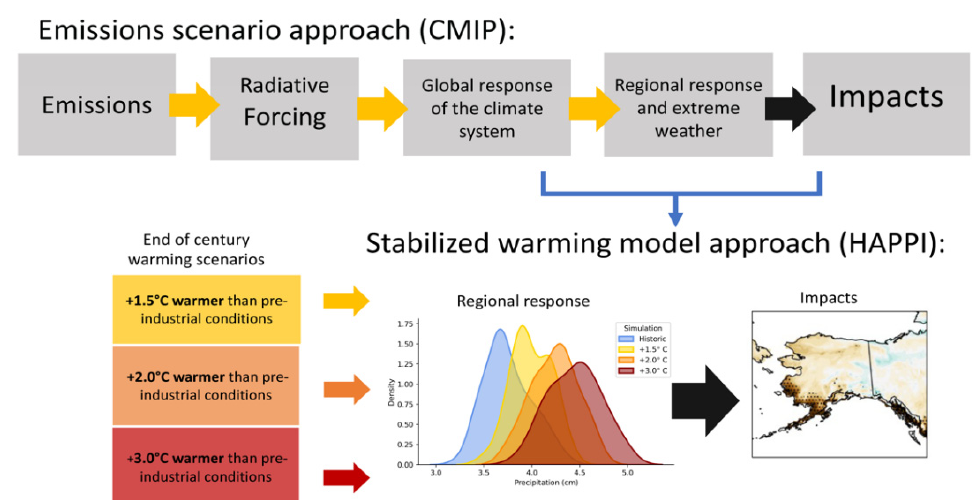
Figure 2. Schematic depiction (adapted from [21]) of a model-derived scenario of future climate (upper row of boxes) and the specific set of HAPPI simulations used to obtain the projections of Arctic change (lower left). Lower middle panel shows the distributions of Alaska precipitation in the HAPPI historical simulation (blue) and the three warming-scenario simulations (yellow, orange and brown for 1.5 °C, 2.0 °C and 3.0 °C global warming, respectively). Lower right panel is a mapping of changes over Alaska. Modified from D. Mitchell et al (2017, Geosci. Model Dev .), reprinted